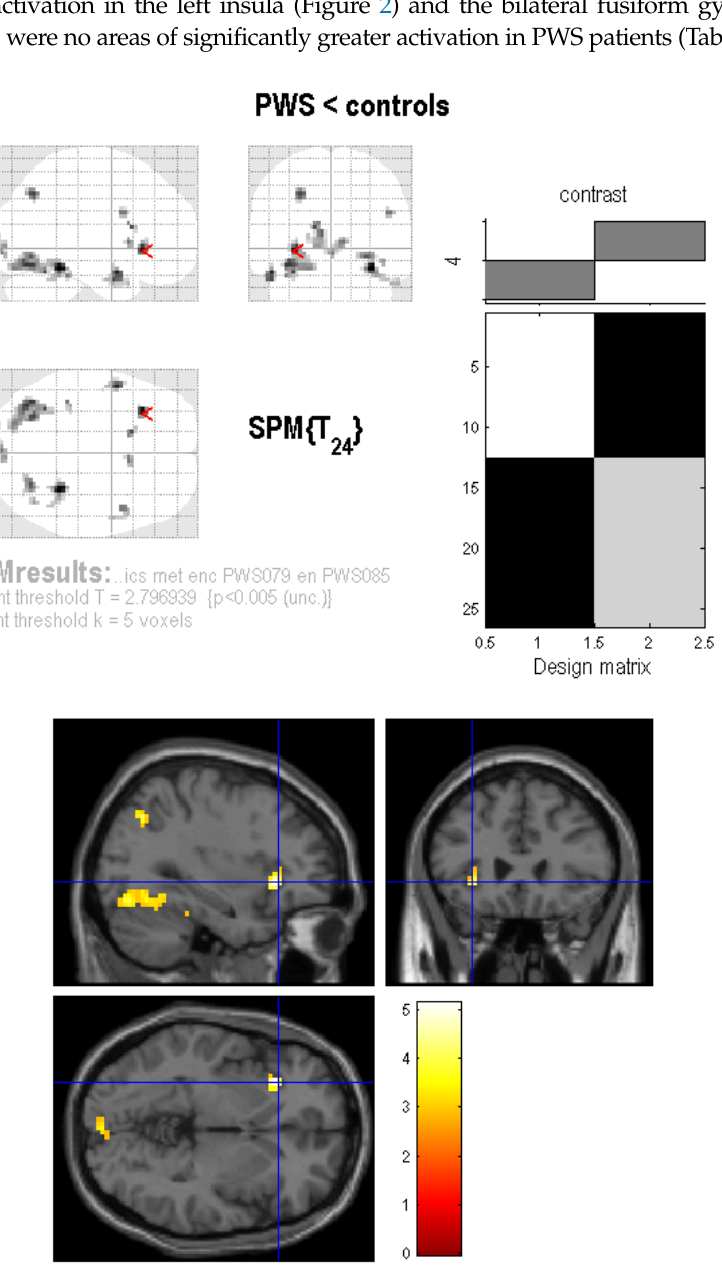
Figure 2. Areas with more brain activation in controls than in PWS patients, for food versus non-food pictures. Upper panel shows area with more brain activation in controls than in PWS patients, for food versus non-food pictures. Lower panel shows significantly higher blood oxygenation level- dependent (BOLD) activation in the left insula in controls than in PWS patients, for food versus non-food pictures (MNI coordinates –33, 24, –3; statistical Z -value = 4.06; p < 0.004 corrected for family- wise-error).